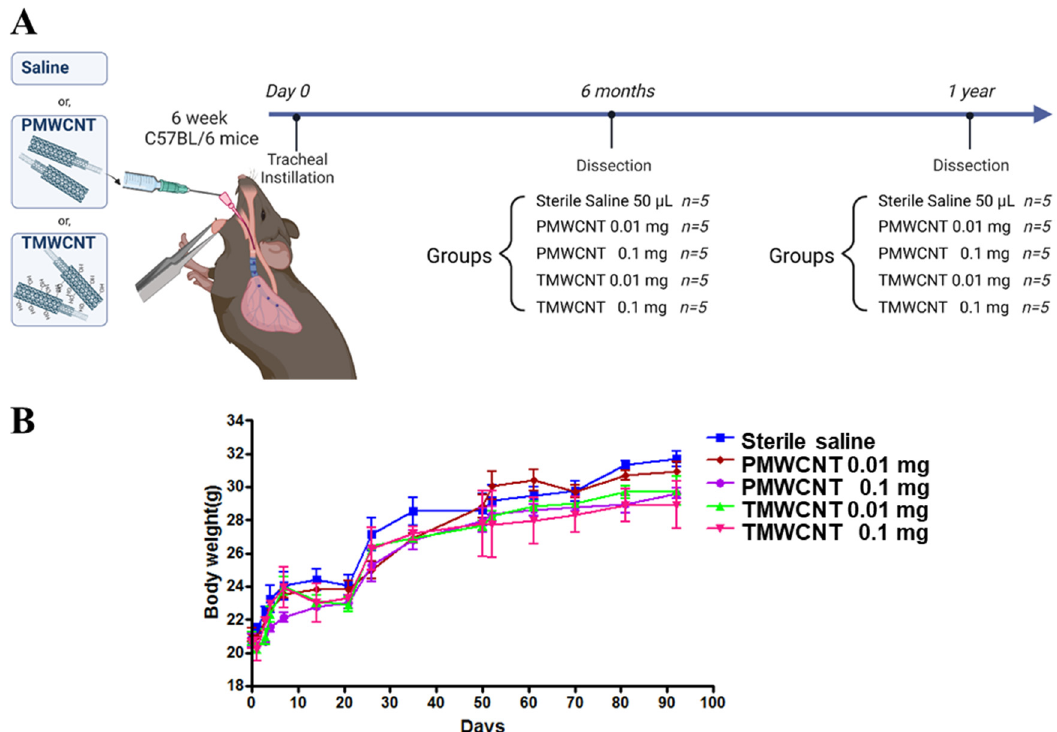
Figure 2. Schematic diagram of the animal experiment and body weight change during 3 months. ( A ) Six-week-old mice were treated with either 50 µL sterile saline, PMWCNTs, or TMWCNTs suspended in sterile saline. Five mice were included in each group, and the concentrations of PMWCNTs and TMWCNTs were either 0.01 mg/50 µL or 0.1 mg/50 µL, with each mouse receiving 50 µL of the respective treatment. The mice were dissected at 6 months and 1 year post-instillation to investigate the long-term effects of the treatments. Created with BioRender.com ( B ) Effects of MWCNTs on mouse body weight gain up until 92 days post-exposure. The average body weight of the control group was 31.7 ± 0.81 g, while the high dosage PMWCNT and TMWCNT groups had an average body weight of 29.59 ± 0.56 g and 28.89 ± 0.83 g each. The average weight of the mice at the start point was approximately 20 g. No toxicity, assessed and defined as a 10% weight loss, was observed up to 0.1 mg/mouse of TMWCNTs and PMWCNTs. Each bar represents the mean ± S.E.M. (n = 5).